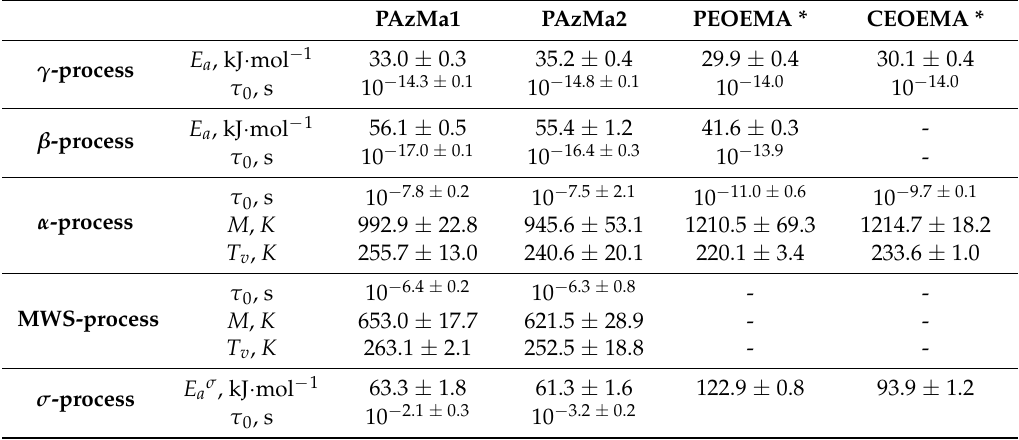
Table 2. Arrhenius ( τ = τ 0 · e − E a / RT ) and Vogel-Fulcher-Tammann-Hesse ( τ = τ 0 · e M / ( T − T v ) ) equations fit parameters for the dipolar and conductive analysed